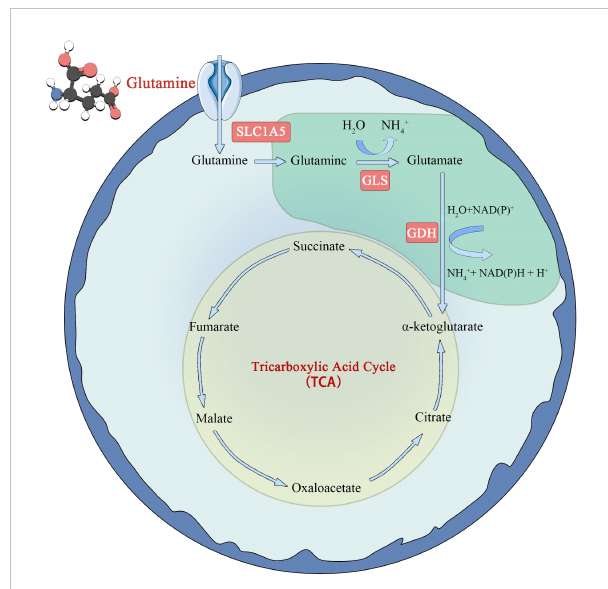
FIGURE 2 Schematic diagram of glutamine metabolism in tumor